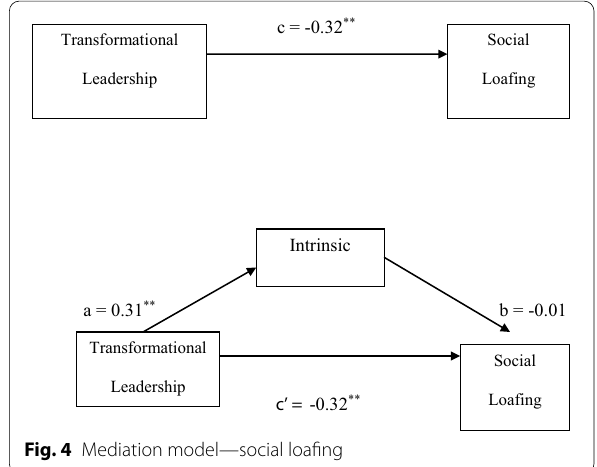
Fig. 4 Mediation model—social